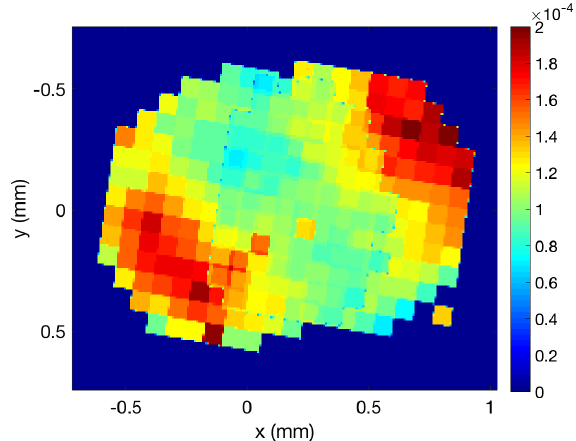
FIG. 9. QE map from combination of two partially overlapping raster scans. Blue region is not scanned by the